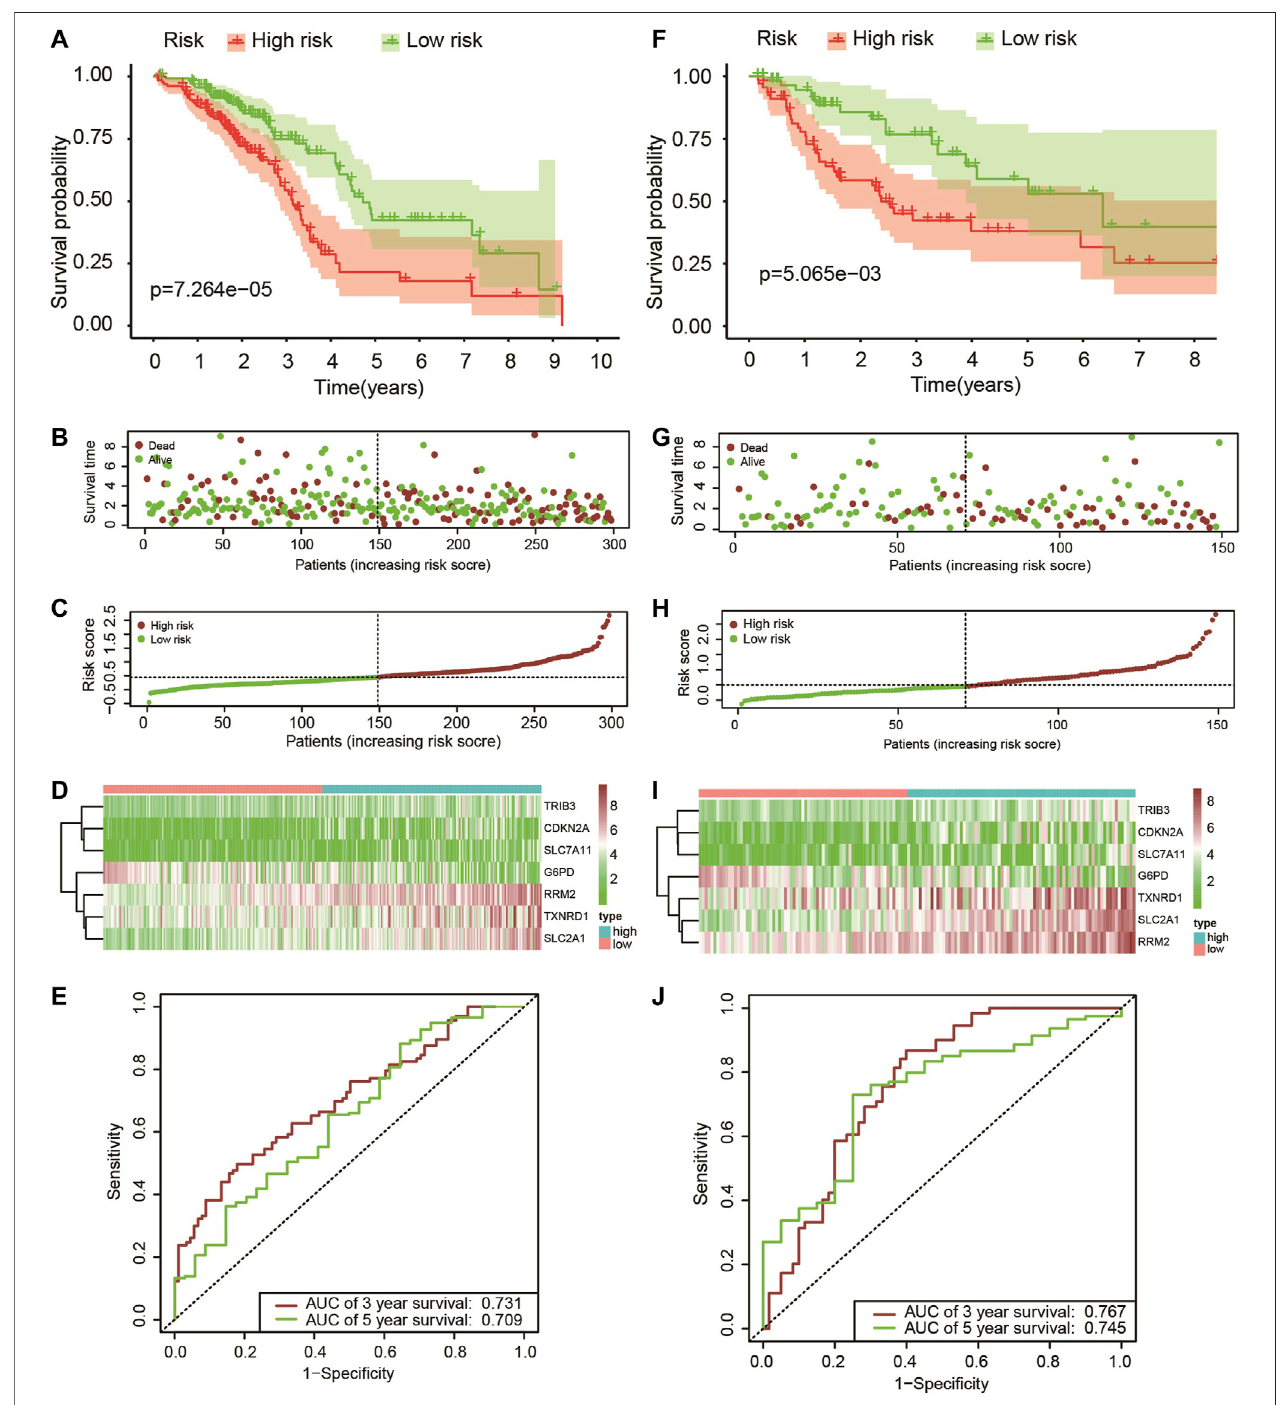
FIGURE 3 | ( A – F ) Kaplan – Meier survival analysis of patients with lung adenocarcinoma in high- and low-risk groups; ( B , G ) The overall survival rate and status of patientswithlungadenocarcinoma; ( C , H )Thedistributionofriskscores;( D , I )Theexpression levelofthesesevenferroptosis-relatedgenesinthelow-riskgroupandthe high-risk group, the cool color represents low expression, while the warm color represents high expression; ( E , J ) 3-years and 5-years ROC curve analysis of the prognostic model.